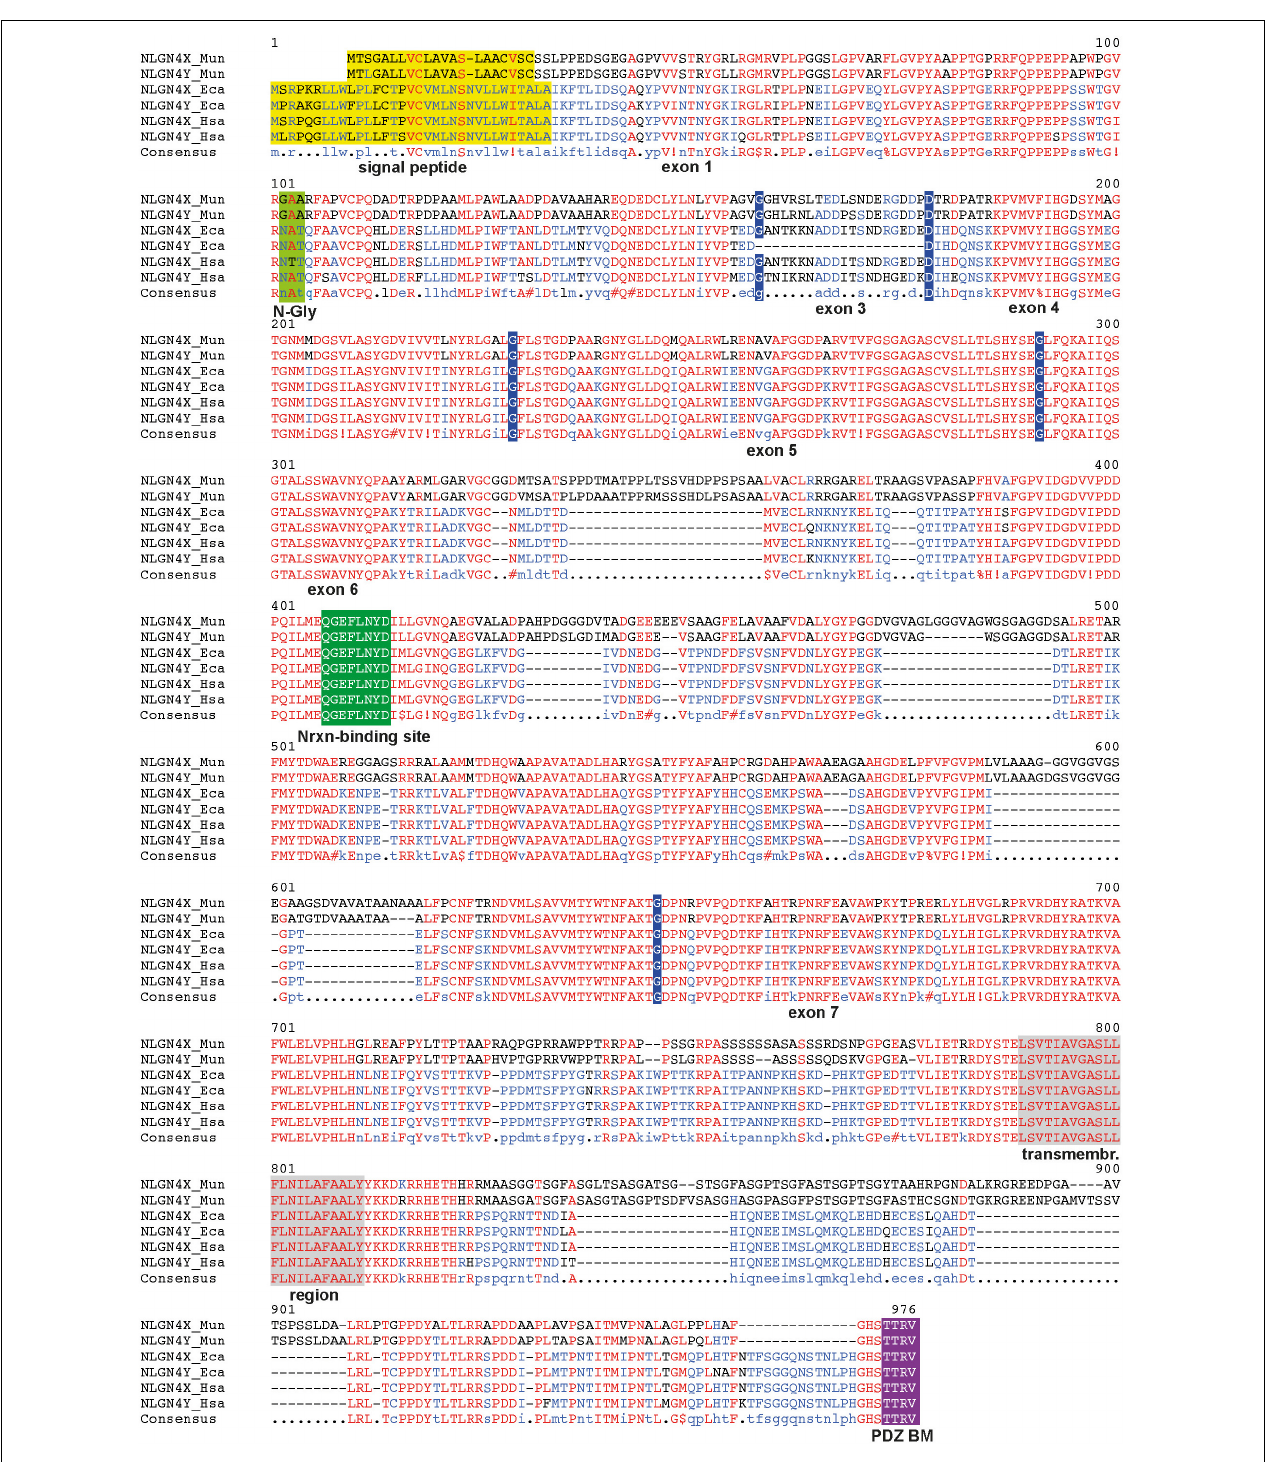
FIGURE 2 | Alignment of NLGN4X and NLGN4Y protein sequences from different species. Key features of the three pairs of neuroligin-4 protein sequences are depicted: exon/exon junctions, indigo; signal peptide, yellow; critical N-glycosylation site (N-Gly) (Cast et al., 2021), lighter green; critical neurexin (Nrxn) binding site (Araç et al., 2007), green; PDZ binding motif (PDZ BM), purple; transmembrane region, gray. The respective name and number of each encoding exon is displayed below the protein sequence. The alignment highlights several insertions exclusively present in the Mongolian gerbil (Mun), that are absent in horse (Eca) and human sequences (Hsa). The alignment was performed using MultAlin (Corpet, 1988). Special characters in the line of the consensus sequence are placeholders for